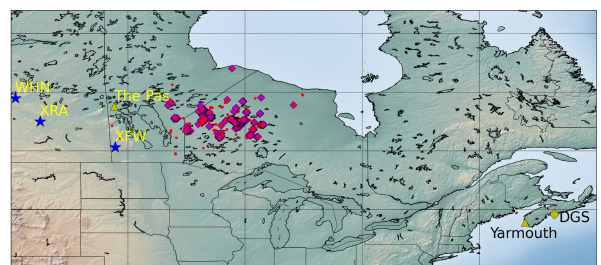
Figure 1. Map of eastern Canada showing all MODIS hotspots from 17 July to 20 July 2011 as detected by the Aqua and Terra satellites. Fires with radiative powers over 100MW are shown as diamonds. The location of the DGS is marked with a yellow diamond in the lower right, while radiosonde stations used in this study (The Pas, Yarmouth) are marked with yellow triangles. Radar facilities men- tioned in the text (WHN, XRA, XFW) are marked with blue